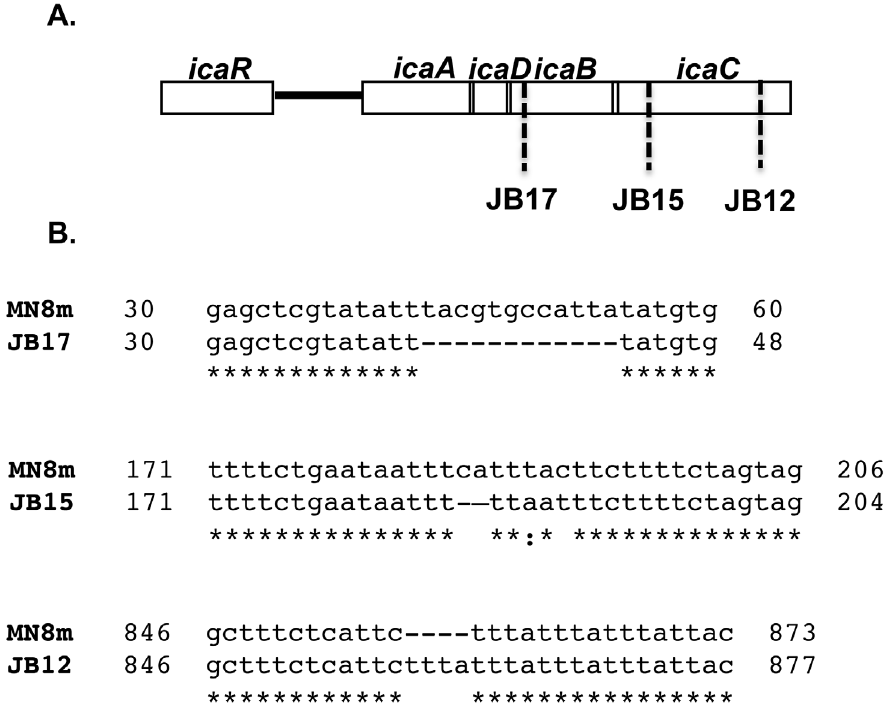
Figure 2. Schematic representation of the ica locus of MN8m and non-mucoid variants. A. The location and B. the sequence of mutations detected in non-mucoid variants of MN8m are shown. The position of the 4 bp insertion in the region of repeats identified in icaC of the non-mucoid variant JB12 is also shown.